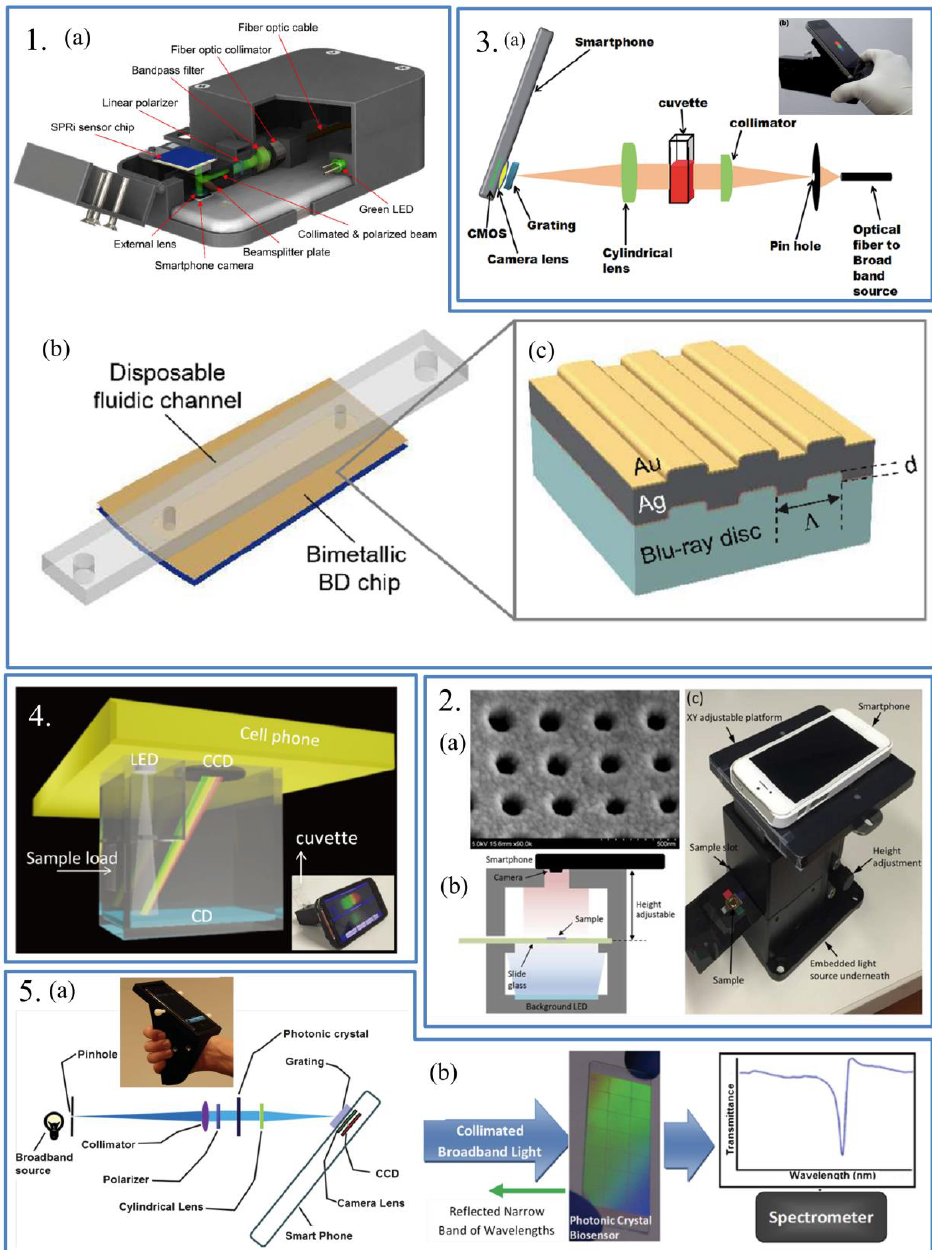
Figure 5. Panel 1: ( a ) Schematic of the smartphone based SPRi platform; ( b ) Schematic of the SPRi chip which integrated a bimetallic Blu-ray disc and a disposable fluidic channel; ( c ) Schematic of the bimetallic Blu-ray disc. Reproduced from [45]. Panel 2: ( a ) SEM image of nanoLCA; ( b ) Schematic of internal optical detection system setup; ( c ) Real image of optical detection setup. Reproduced from [46]. Panel 3: ( a ) Schematic of the smartphone-based LSPR sensing platform. Insert: photograph of the smartphone-based LSPR sensing platform. Reproduced from [8]. Panel 4: Schematic of the smartphone spectrometer for colorimetric biosensing. ( b ) Insert: Photograph of the smartphone spectrometer. Reproduced from [47]. Panel 5: ( a ) Schematic of the optical components within the smartphone cradle; ( b ) Working principle of the smartphone-based photonic crystal biosensor. When the photonic crystal was illuminated with a wide range of wavelength, only a narrow band of wavelengths was reflected, while the spectrometer recorded all other wavelength transmitted through the photonic crystal. Insert: Photograph of the cradle with a photonic crystal biosensor slide inserted into the detection slot. Reproduced from